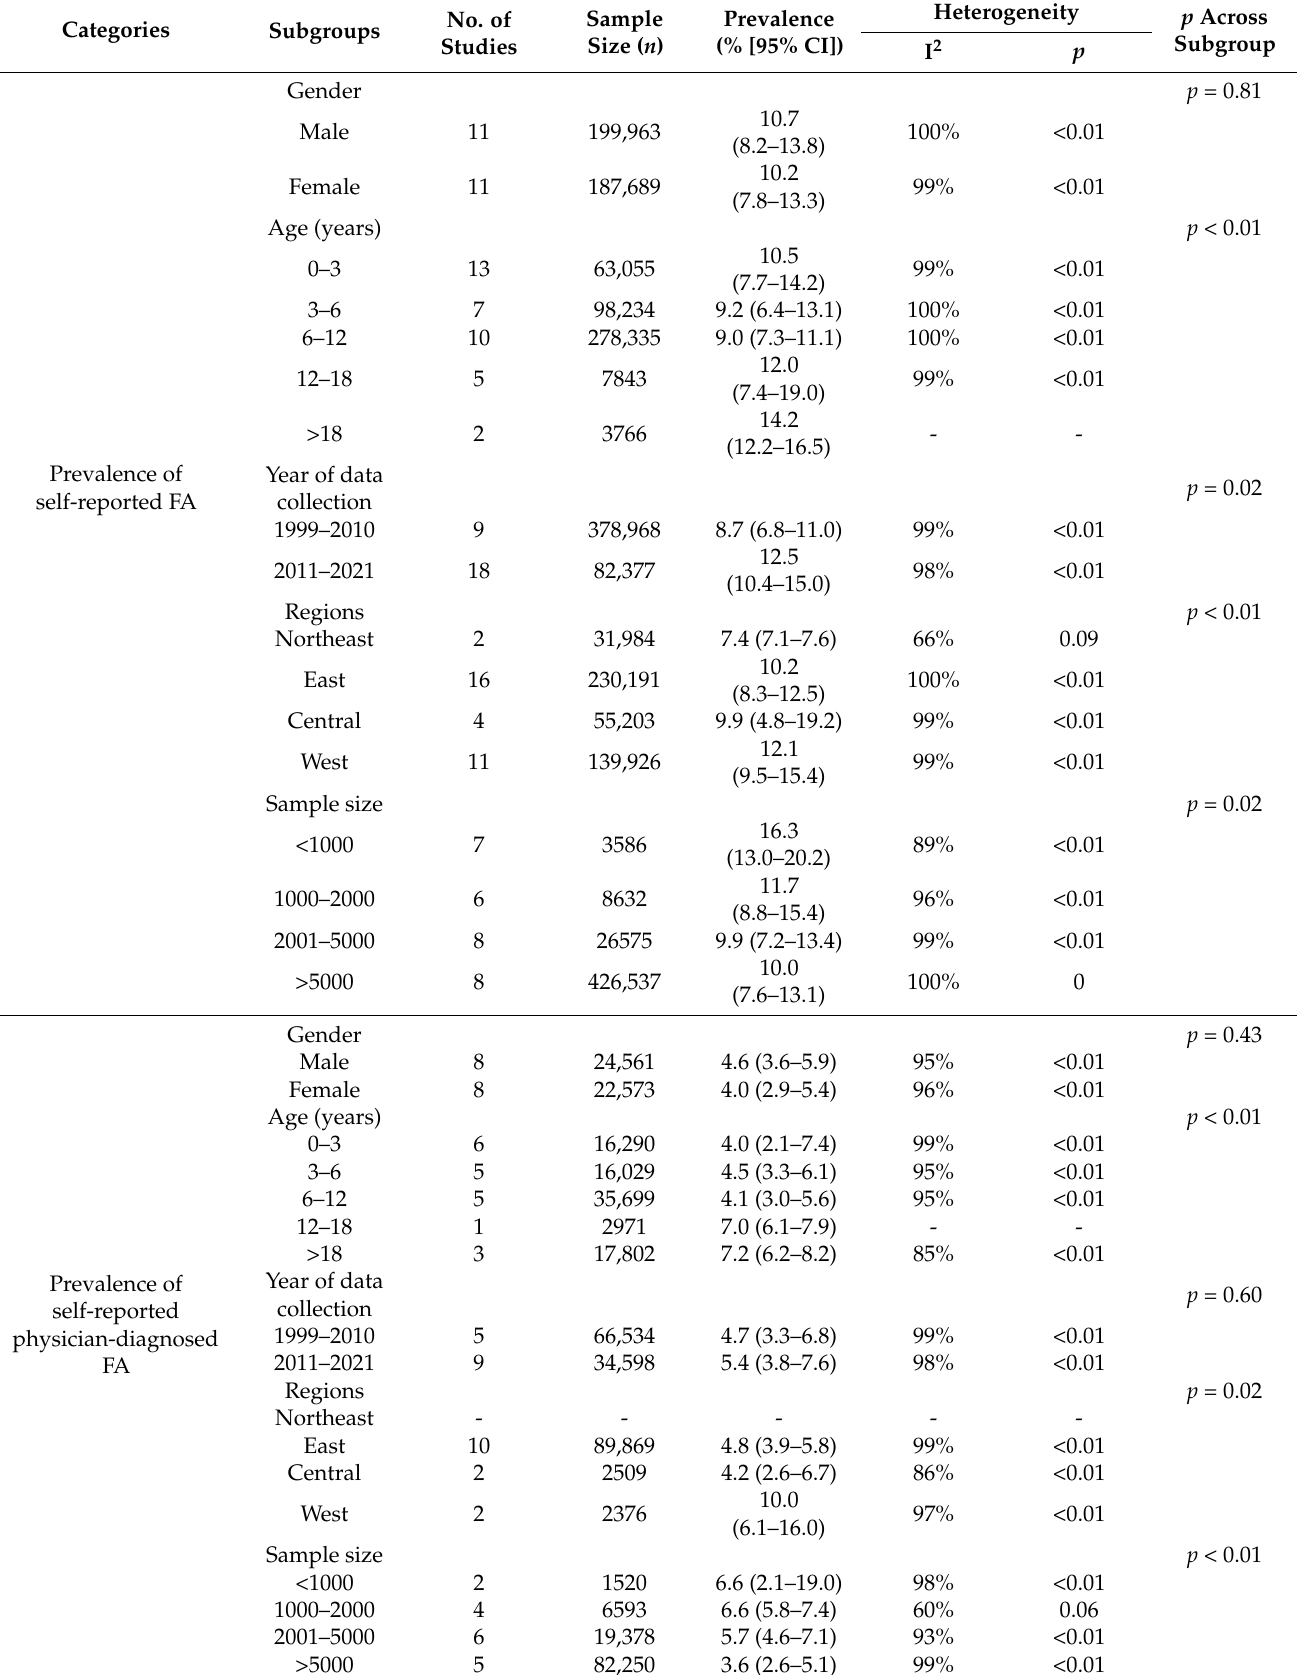
Table 2. Subgroup analyses of the prevalence of FA in